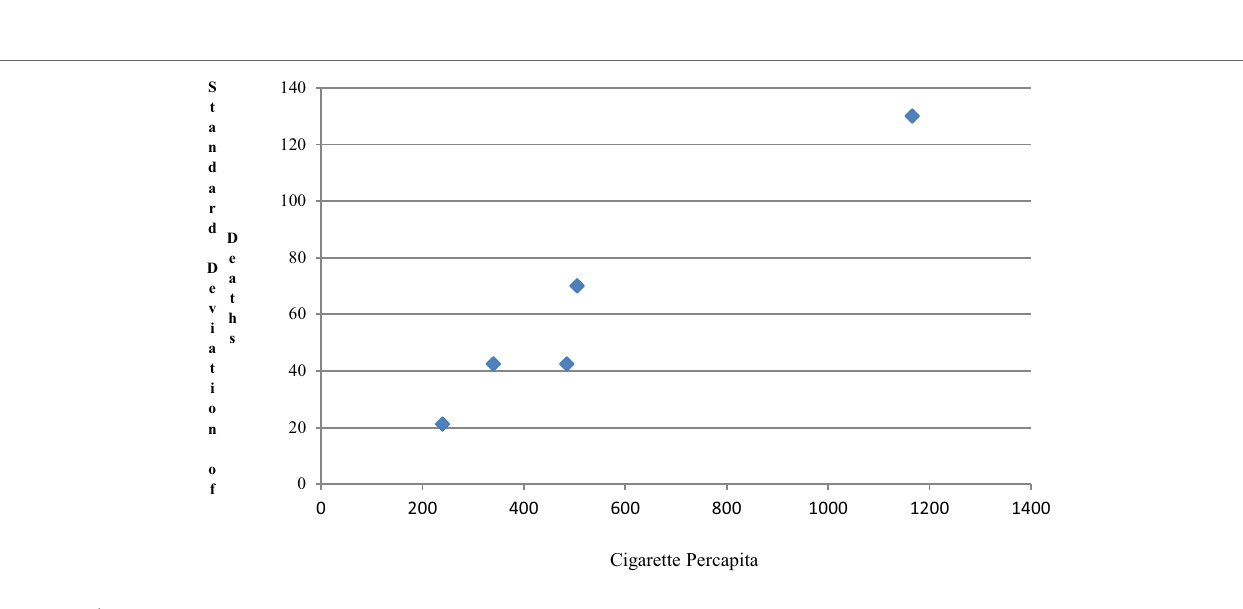
FiGURe 2 | The SD changes by average cigarette